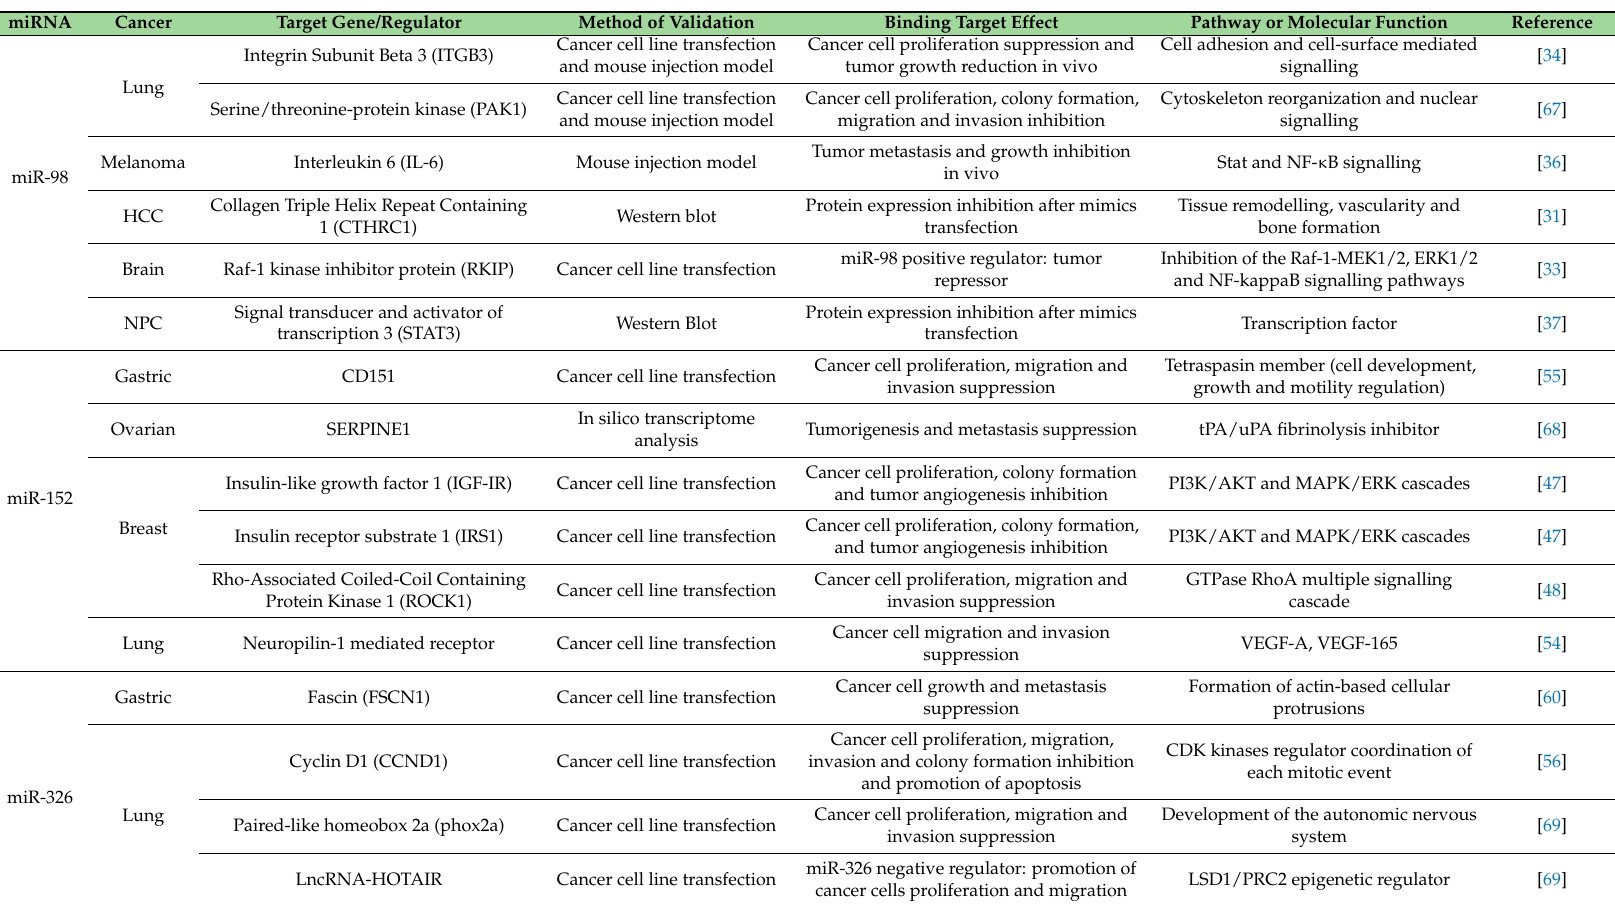
Table 3. Functional role of the miRNA signature in